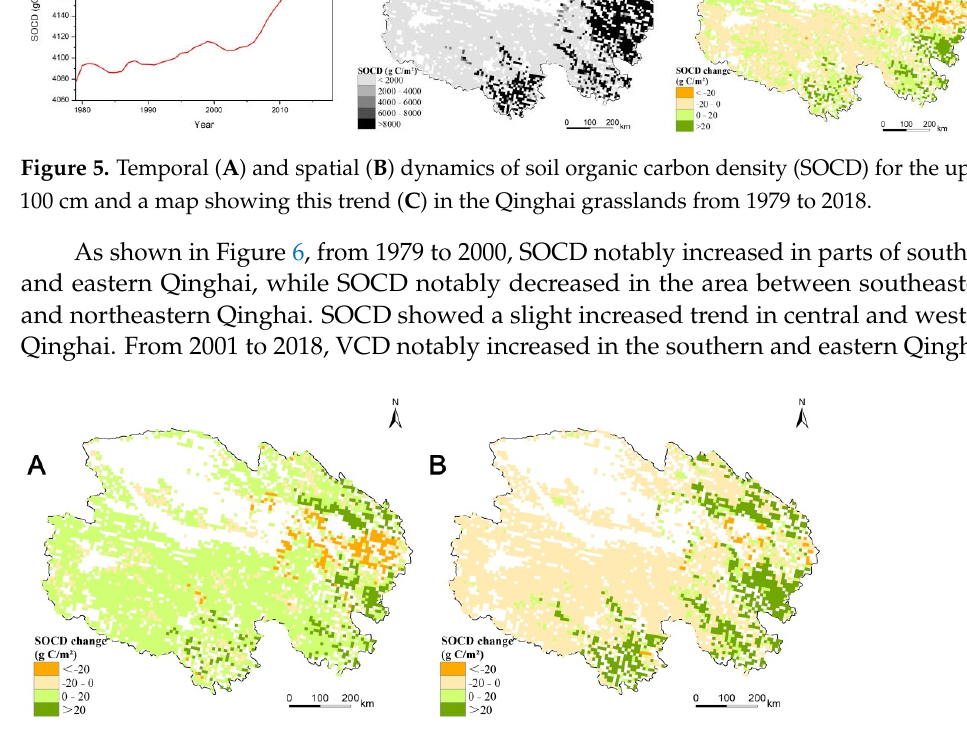
Figure 6. Soil organic carbon density (SOCD) change in the Qinghai grasslands from 1979 to 2000 ( A ) and from 2001 to 2018 ( B ).